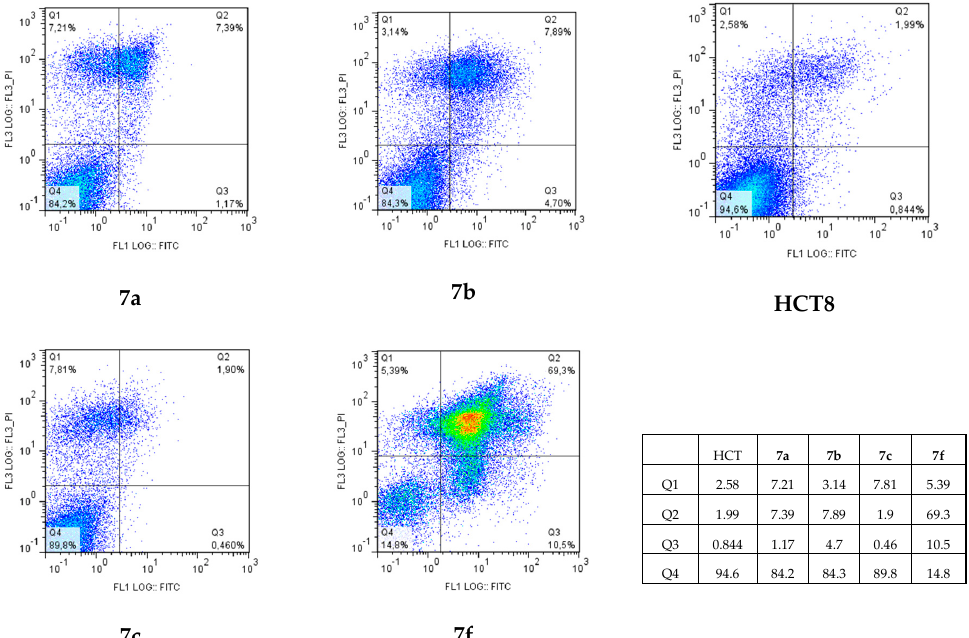
Figure 1. Analysis of apoptosis by flow cytometry. The dot plot figures show the following populations: necrotic (Q1—upper left), late apoptosis (Q2—upper right), early apoptosis (Q3—lower right), and viable cells (Q4—lower left).